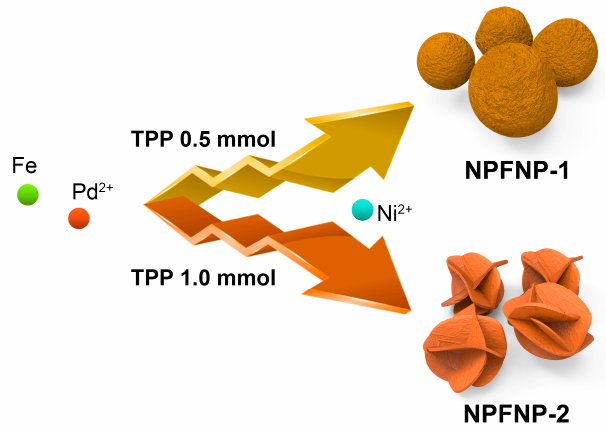
Scheme 1. Illustration of synthesis of NPFNPs with controlled morphology using TPP as capping